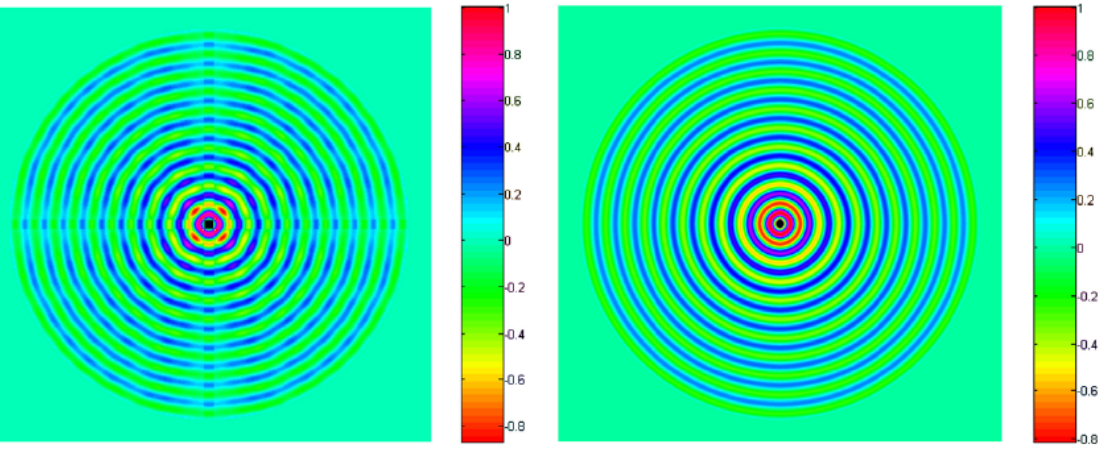
Figure10. Downward view of normalized harmonic radiation field for out-of-plane surface displacement in an aluminum plate at 100 kHz, the A actuators and (b) (right) circular actuators. Taken from Raghavan and Cesnik